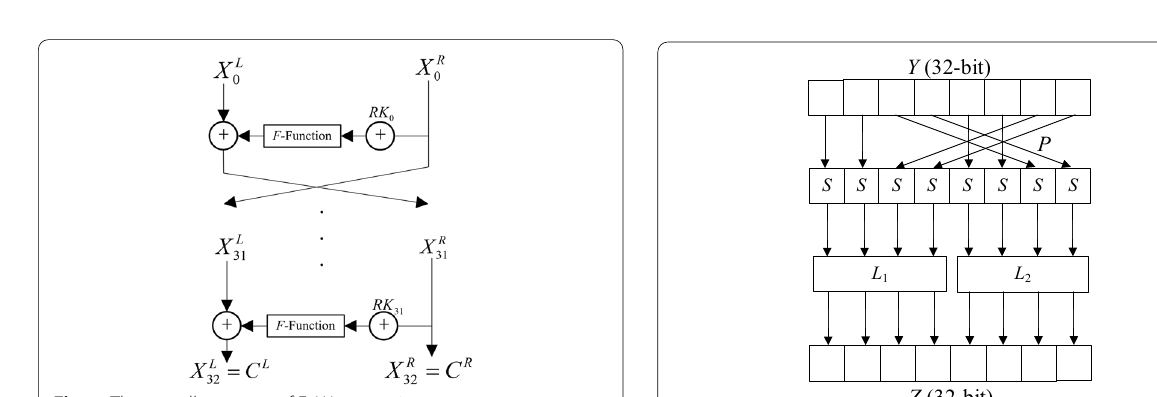
Fig. 1 The overall structure of FeW encryption